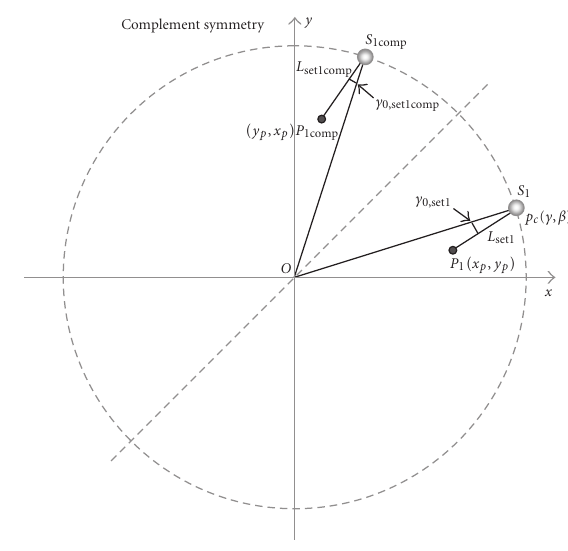
Figure 5: Right-angle symmetry. Four pairs of source and pixel po- sitions share the same L and y 0 .